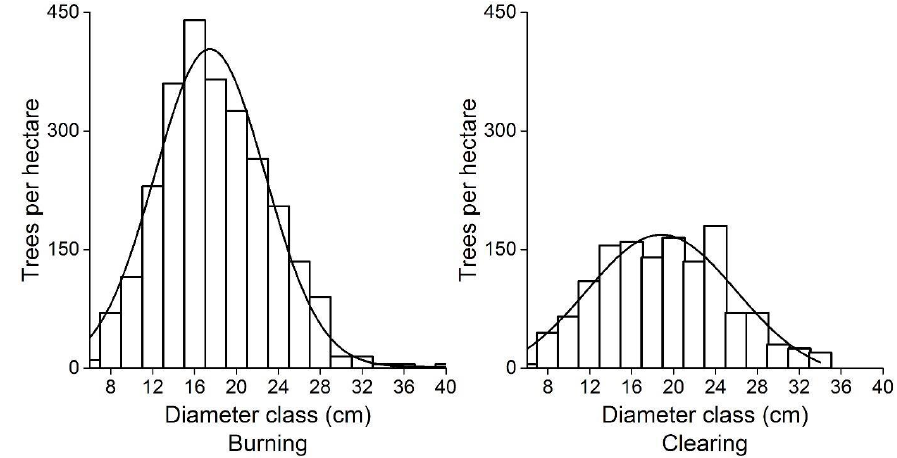
Figure 2. Trees · ha − 1 (only for Chinese fir) of each diameter class for the burning and clearing preparation sites. The smooth curves are Gaussian fits to the data.